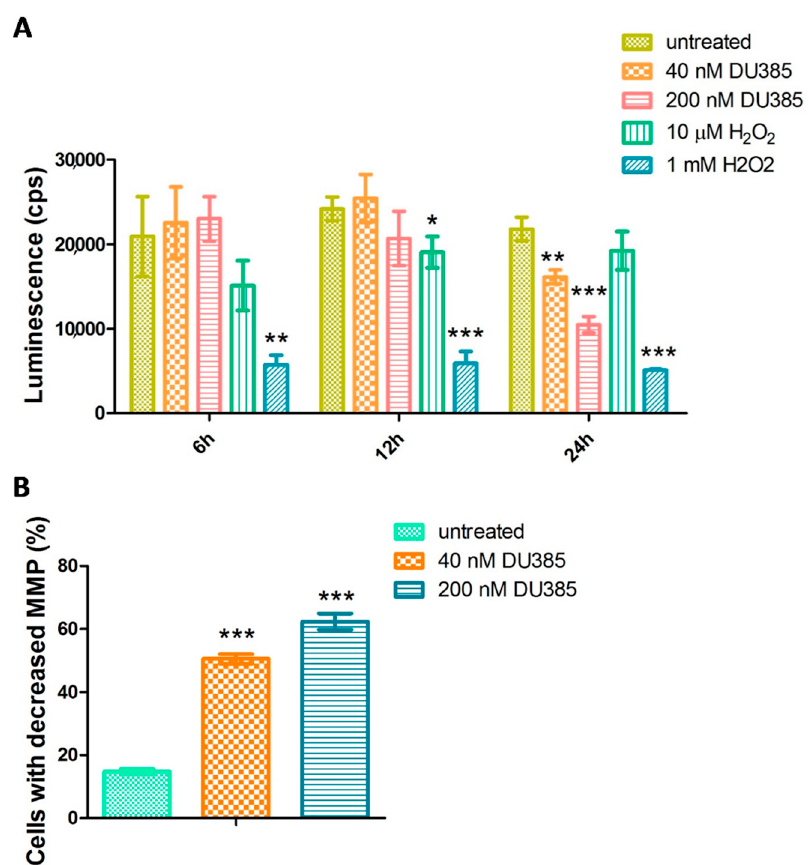
Figure 4. Imidazo[1,2- b ]pyrazole-7-carboxamide DU385 exerted oxidative stress of MV-4-11 cells. Reduction of the glutathion (GSH) level ( A ) and the loss of the mitochondrial membrane potential (MMP) ( B ) were detected after 24 h as described in Section 4.7 Materials and Methods. * p < 0.05, ** p < 0.01, *** p < 0.001.